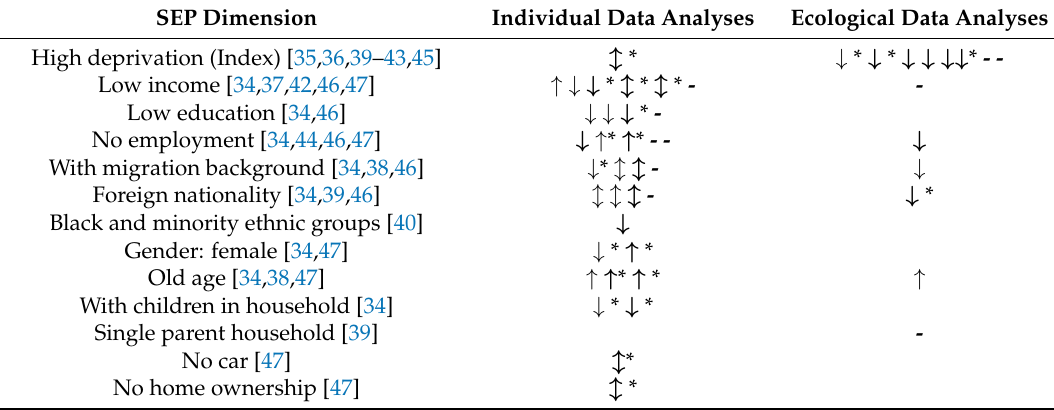
Table 4. Summary of relationships between measures of SEP and environmental resources. SEP